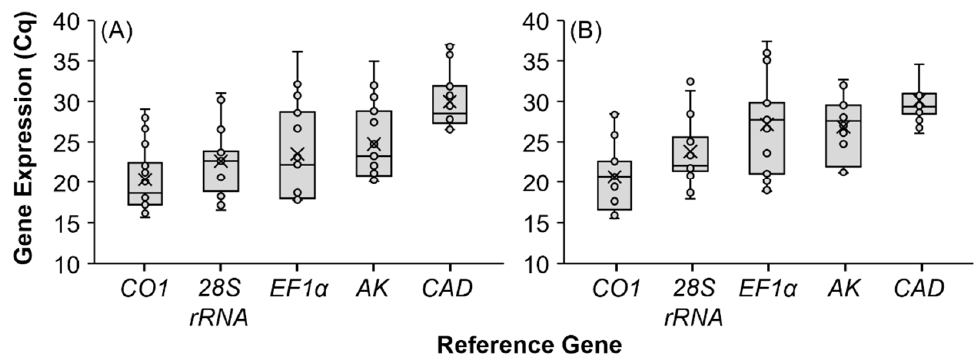
Figure 3. Expression in quantification cycle (Cq) values of five reference genes ( 28S , 28S ribosomal RNA; AK , arginine kinase; CAD , carbamoyl-phosphate synthetase 2-aspartate transcarbamylase-dihydroorotase; CO1 , cytochrome oxidase subunit 1; EF1 α , elongation factor 1- α ) as represented by pooled Cq values obtained for whole body and all dissected tissue types from ( A ) laboratory-reared and ( B ) field-collected samples of X. germanus . Three technical replicates were analyzed for each of the three biological replicates that were prepared from each of the tissue types from laboratory-reared and field-collected specimens to generate the quantification cycle (Cq) values. The resulting Cq values from the technical replicates were then averaged and the mean values were used to prepare the boxplots for each reference gene. Data include six pooled tissue types for laboratory-reared specimens and five pooled tissue types for field-collected specimens.